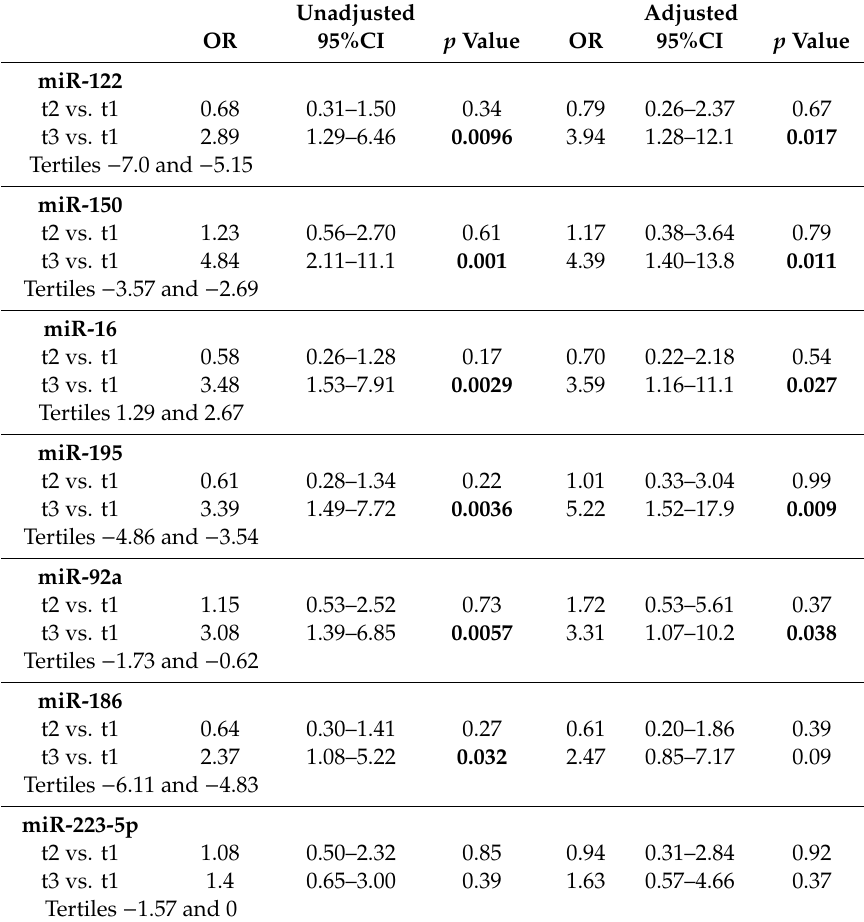
Table 3. Univariate and multivariate logistic regression analysis for the risk of